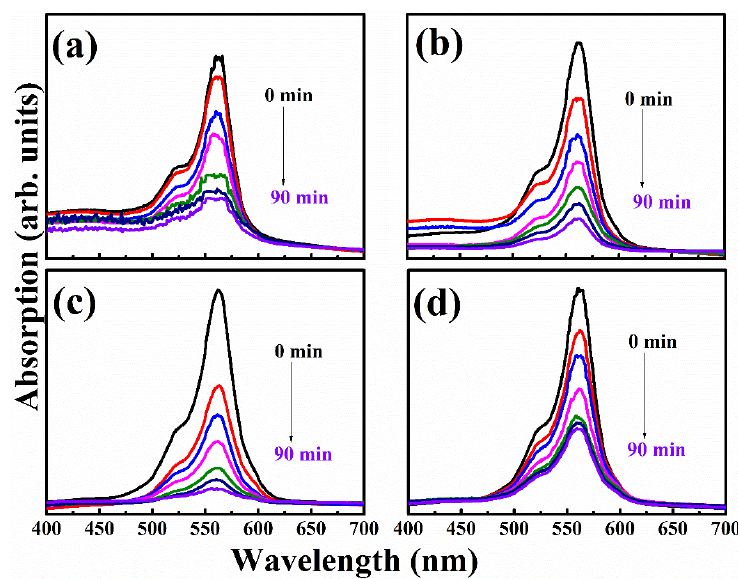
Figure 6. Time-dependent UV–Vis absorption spectra for RB dye in the presence of Catalyst: ( a ) pure Fe 2 O 3 , ( b ) Zn 2%, ( c ) Zn 4% and ( d ) Zn 6%.